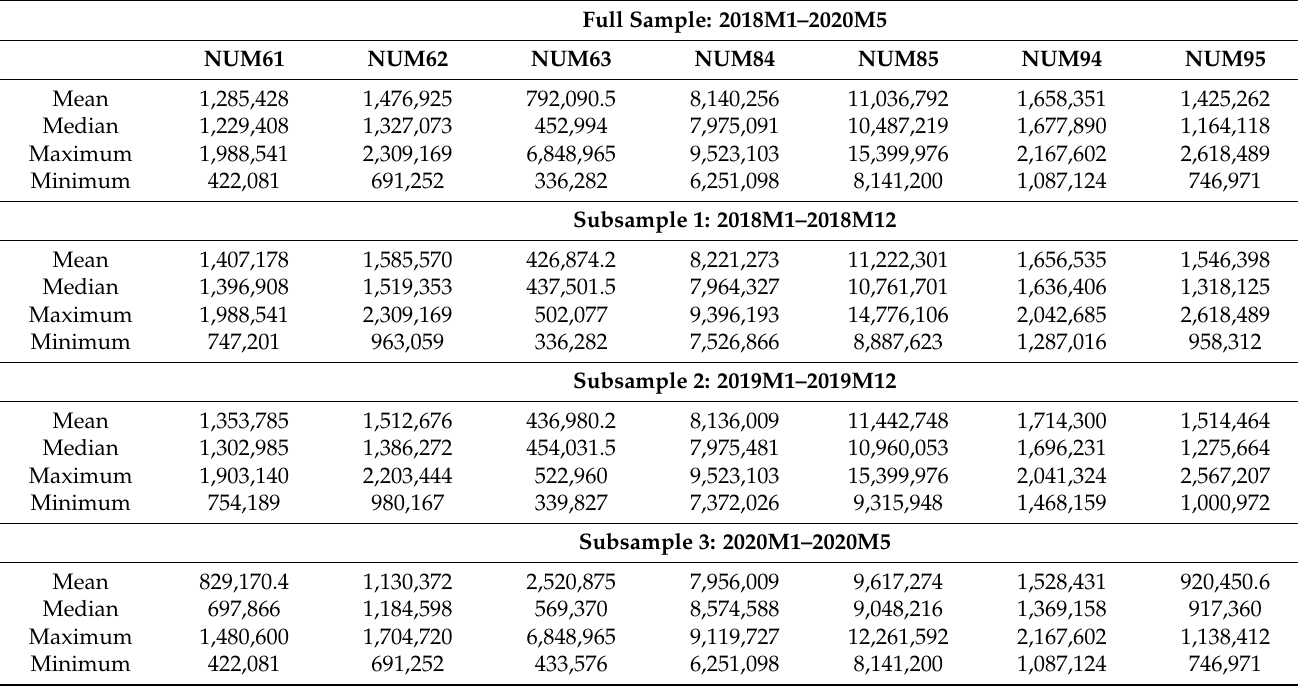
Table 3. Descriptive statistics ($) of imports of EU-15 for samples and